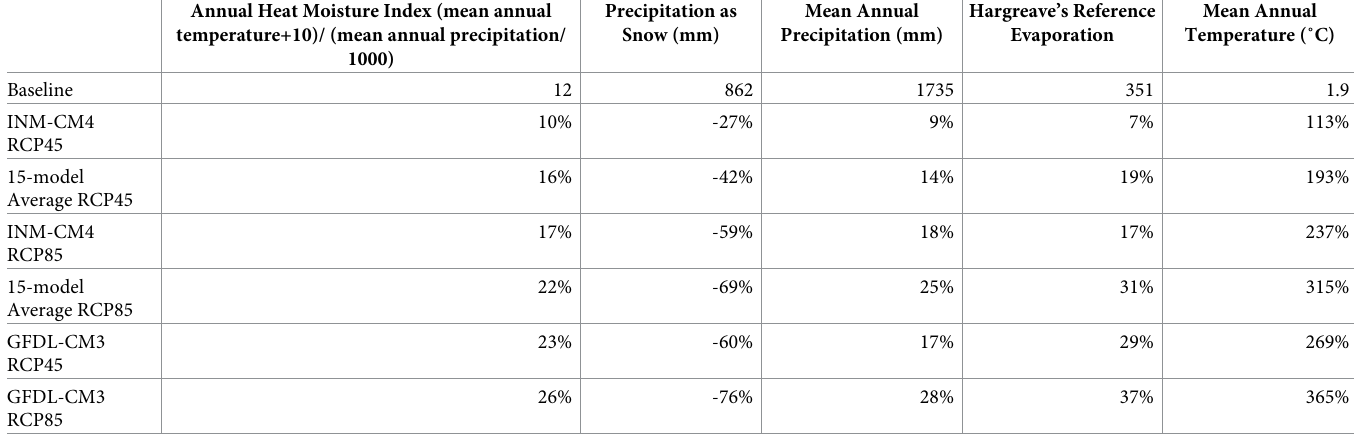
Table 4. Climate variable summary. Average values of Adaptwest baseline (1960–1990) climate for the Kenai Peninsula, Alaska. We summarized annual heat moisture index, precipitation as snow, mean annual precipitation, and Hargreve’s reference evapotranspiration because these are the 4 highest variables ranked for importance in the Random Forest model. We summarized mean annual temperature because temperature interacts with precipitation to calculate the annual heat moisture index and Hargreaves reference evaporation. We calculate the percent change from baseline for the 6 future climate forecasts using 3 GCMs and 2 RCPs in